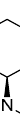
Figure 7. Takemoto’s thiourea organocatalyst [110–112].